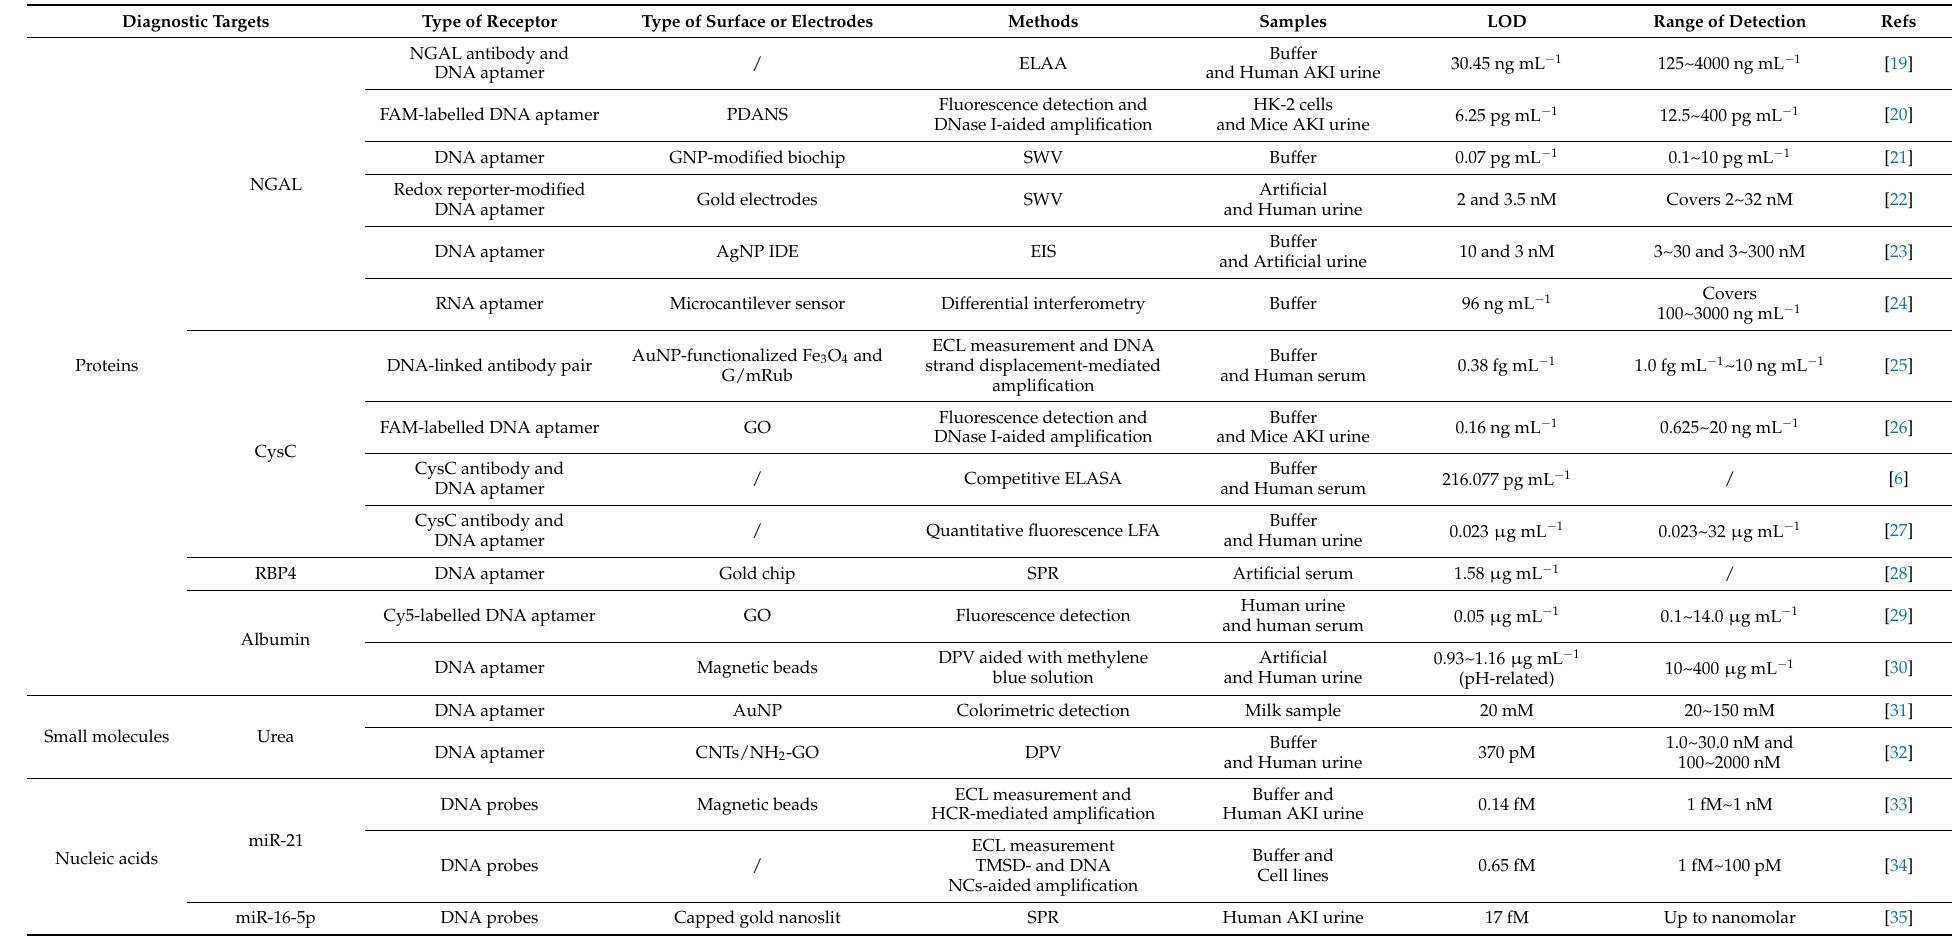
Table 1. A summary of extant nucleic acid nanotechnology-based diagnostics towards AKI-related